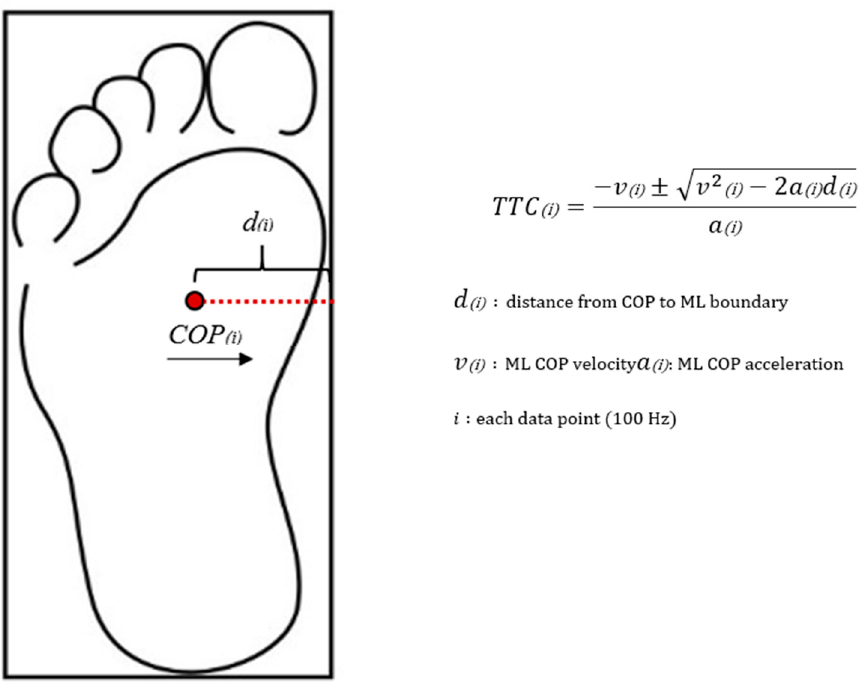
Figure 2. Illustration of the rectangular boundary of the foot and the Time-to-Contact (TTC) calcula- tion. v and a (COP velocity and acceleration) were calculated using the first central difference method.